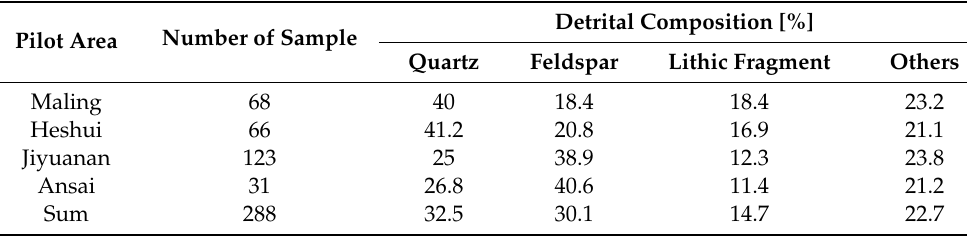
Table 1. Detrital components for the four pilot areas in Chang 7.